Question: Give a one-sentence summary of this figure.
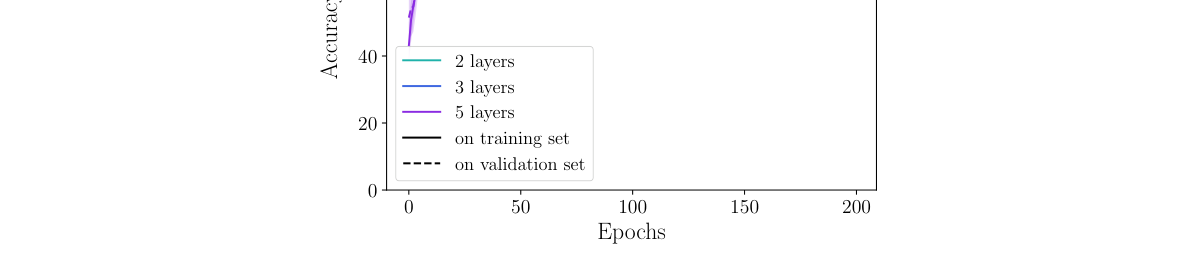
Answer: Evolution of the training and validating accuracies of SRC networks with 2, 3 and 5 layers on the Fashion MNIST with latency-based coding.